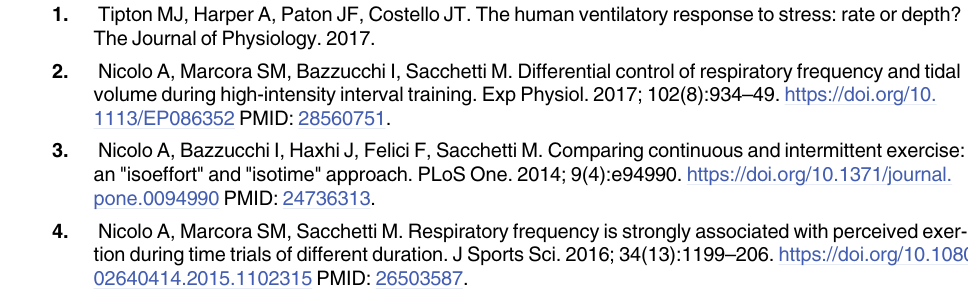
S1 Table. Matched-pair demographics. For each case (GWI+) and control (GWI-) pair, we report i) race and ethnicity, ii) birth sex, iii) age in years, iv) height in centimeters, and v) forced vital capacity (FVC). Absolute differences for each variable for each pair ( Δ = case— control) are reported for age, height and FVC. Overall, we were able to match evenly by sex and race/ethnicity. Other factors were very similar as indicated by the low average differences observed for age (3.7 years), height (6.5 cm), and FVC (0.2 L). Note that acceptable and repeat- able spirometry were not available for one Veteran (pair